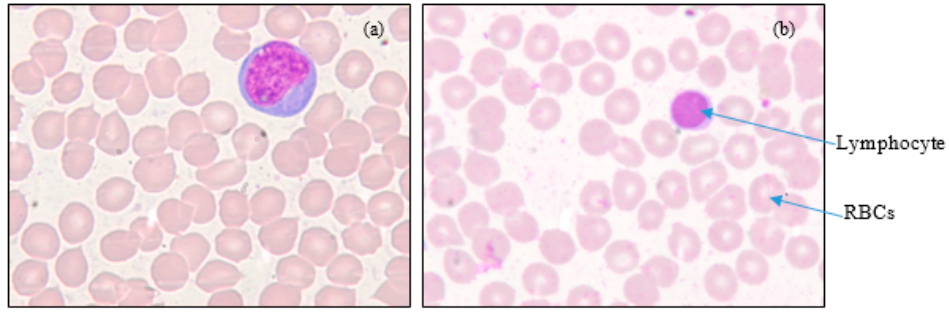
Figure 2. 100x digital microscopic PBS images: ( a ) Dengue (reactive lymphocyte), and ( b ) Normal. (Courtesy: KMC, Manipal).